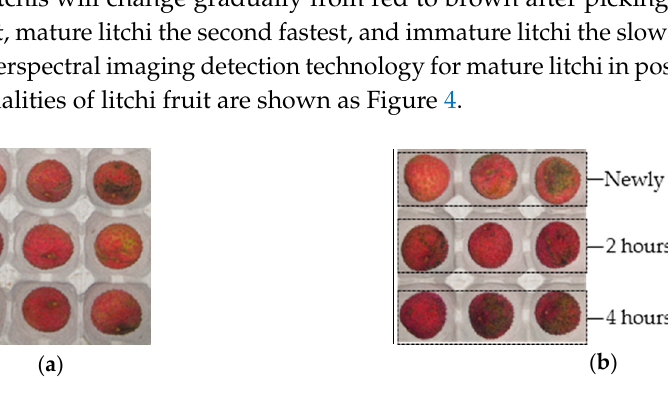
Figure 4. Litchi images of different qualities. ( a ) Fresh mature litchis, ( b ) Micro-damage litchis of different qualities.